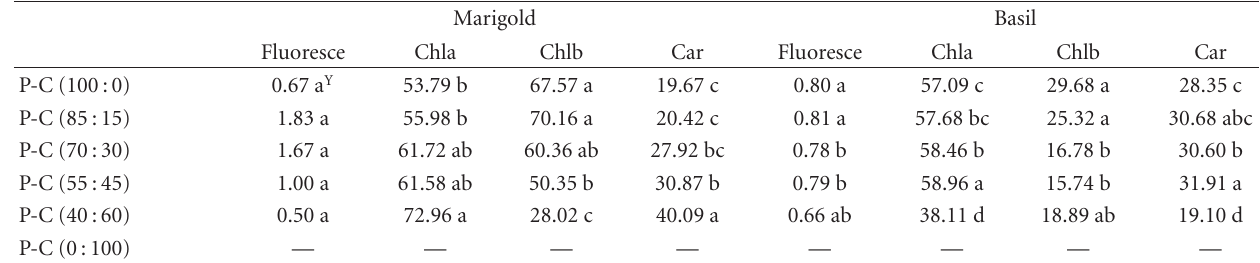
Y Values ( n = 6) in columns followed by the same letter are not significantly di ff erent, P ≤ 0 . 05.